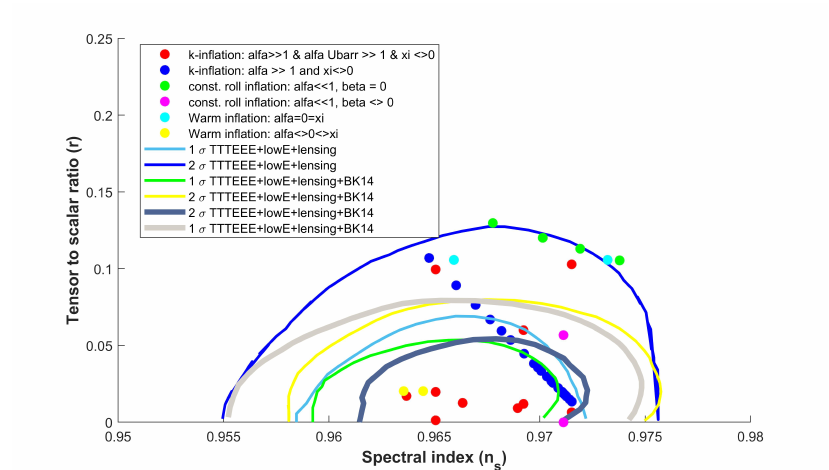
Figure 1. Kinematically derived inflation, in a model of varying strong coupling constant φ ( x ) ), with f ( R ) gravity via α R 2 term and non-MCtG − ξ R φ 2 term. The blue points ( g st ( x ) = g st 0 correspond to the limit where α >> 1, and we imposed ξ = 1. The red points correspond to the limit α >> 1 and α ¯ U >> 1 with ξ (cid:54) = 0. The green (pink) points correspond to the limit α << 1 with ξ = 0 and a vanishing (nonvanishing) constant-roll parameter β . The yellow (sky blue) points correspond to warm inflation scenario with (without) f ( R ) gravity. The models are contrasted to Planck 2018, separately or combined with other experiments, contour levels of spectral parameters ( n s , r ). All acceptable points correspond to (cid:96) >